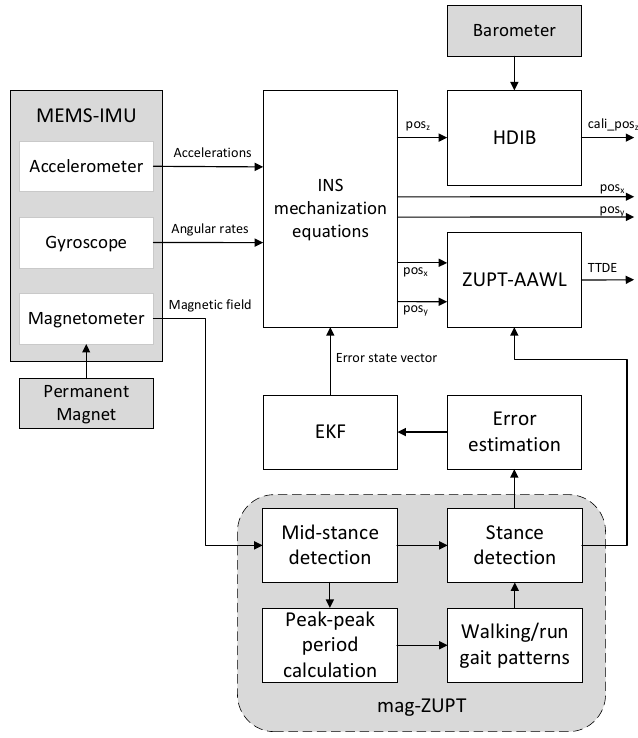
Figure 3. Flowchart of the pedestrian navigation system with EKF and ZUPT.